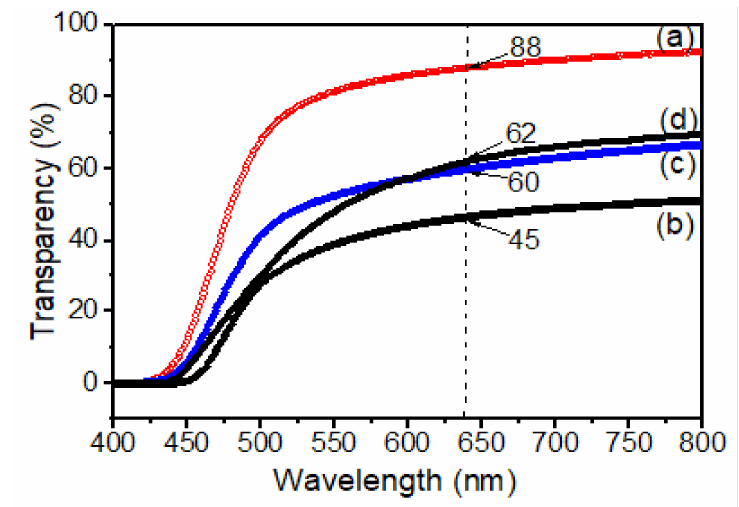
Figure 5. UV spectra of various samples: ( a ) pure PI, ( b ) PI-TSi; ( c ) PI-TSi-GPMS50; and ( d ) PI-TSi- GPMS75. The values of all films at 638 nm are inserted in Figure 5.